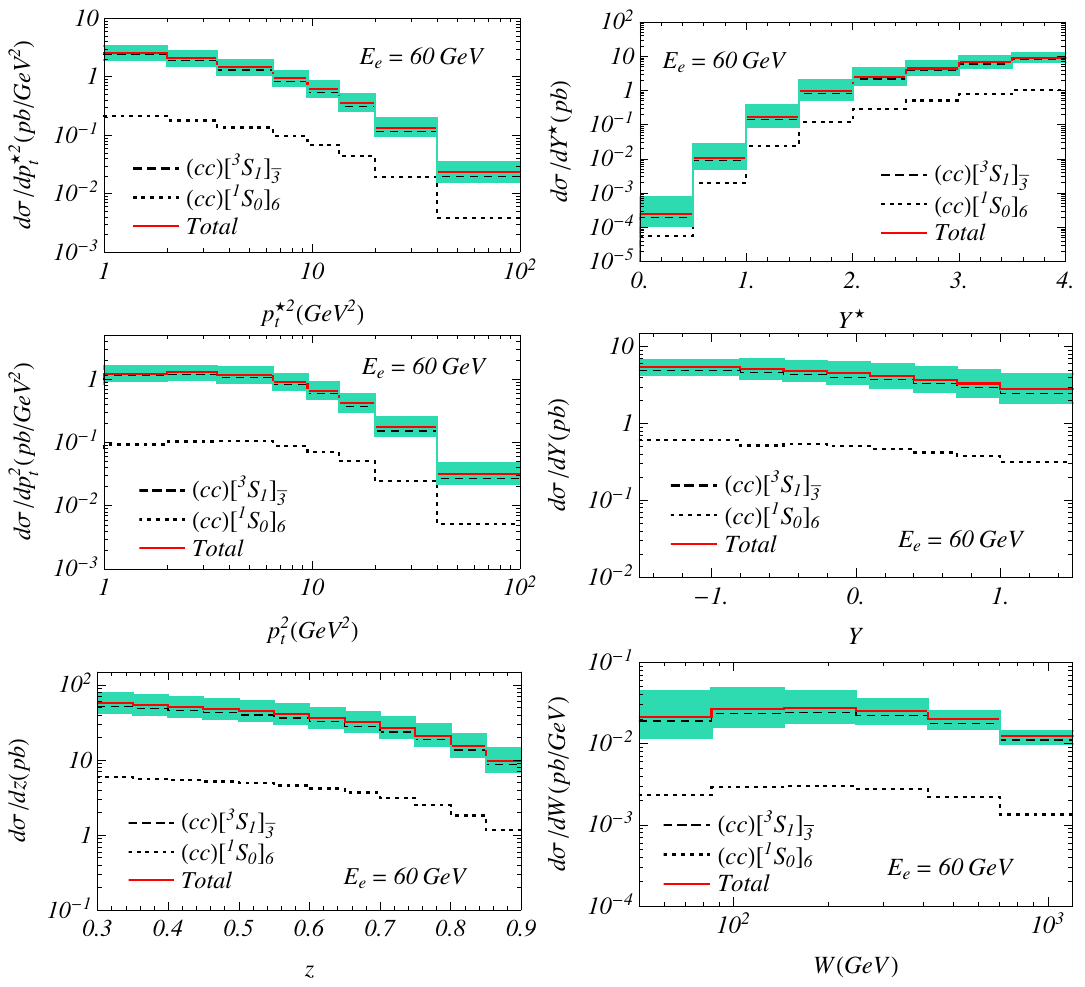
Figure 4 . The distributions of p 2 kinematic cuts in equation (3.1), corresponding to E e = 60 GeV. \ Total " denotes the sum of the contributions via ( cc )[ 3 S 1 ] (cid:22) 0 : 5 (cid:22) 0 to 2 (cid:22) 0